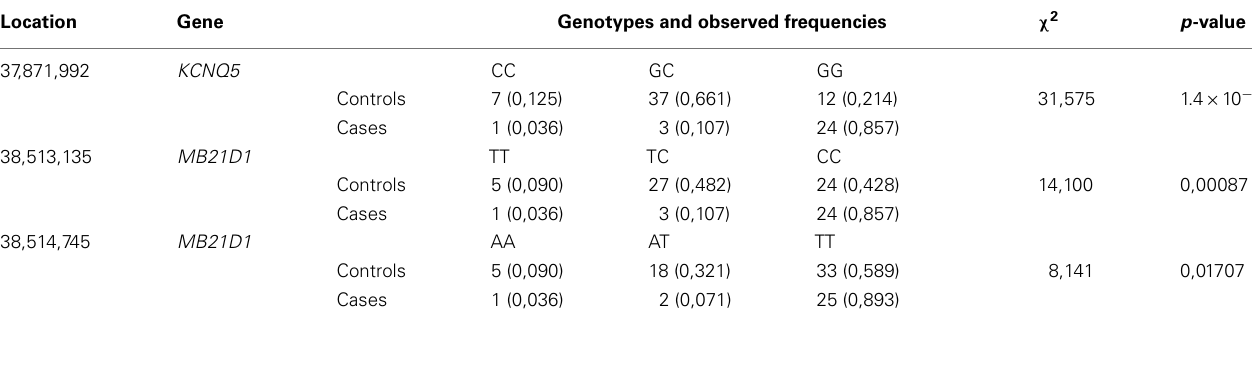
Table 3 |Test of association between SNPs and disc